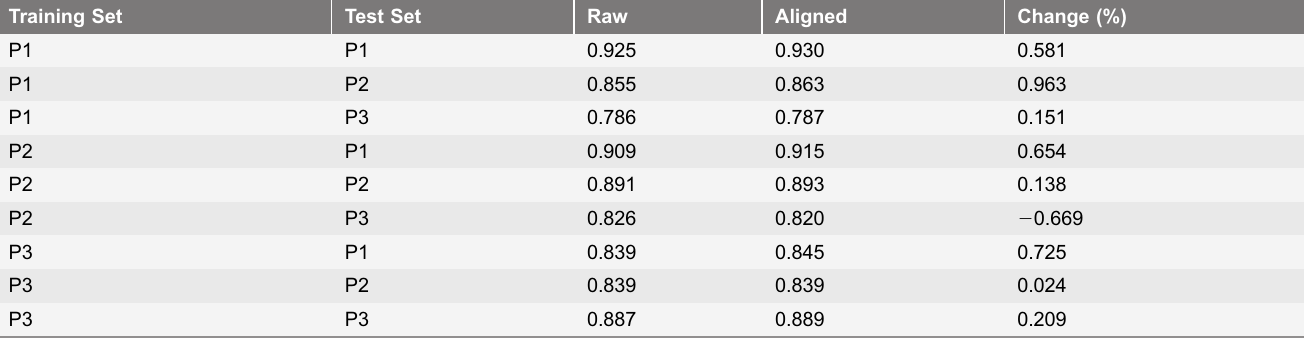
Table 4. Focus alignment prior to training of the algorithm improves the F1-score a